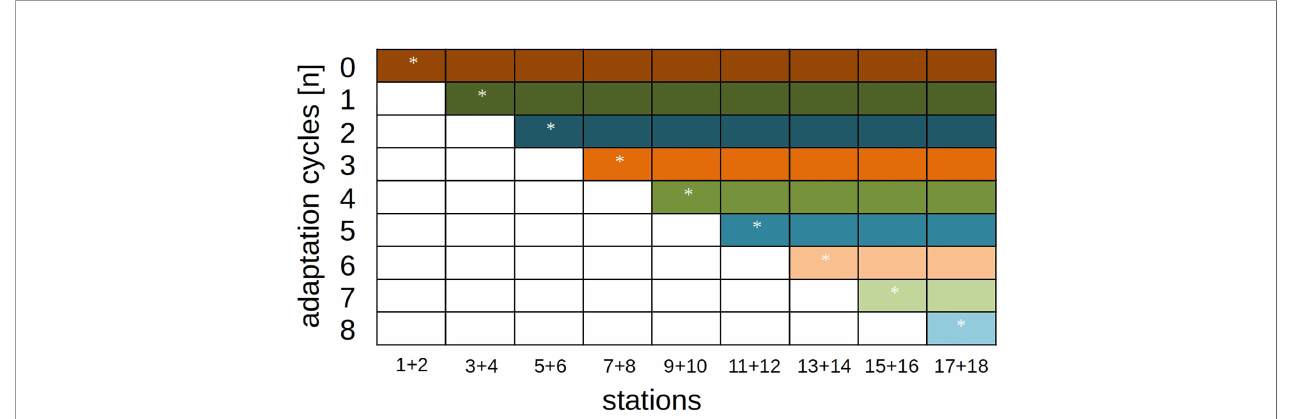
FIGURE 4 | Model-adaptation/station-classi fi cation schedule for performance analyses. The diagonal row (marked with stars) represents the fully-adaptive implementation of the DOC pipeline, where an adaptation is implemented every second station. All colored rows show reference runs where samples are classi fi ed with an existing model and without further